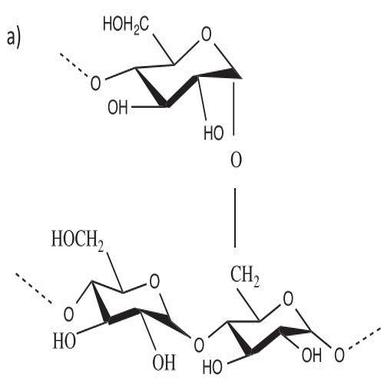
Structure of (a) amylopectin and (b) amylose. Reproduced from with permission.